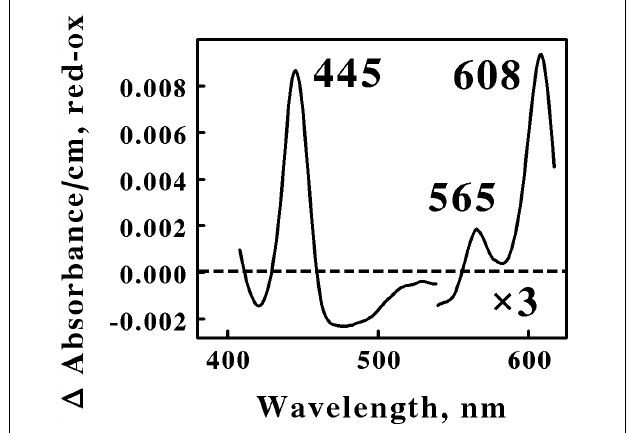
FIGURE 1 | Reduced minus oxidized difference spectra obtained when excess ferrous sulfate was mixed with intact cells of Acidihalobacter ferrooxidans , representing the Proteobacteria. The number of cells present in 8 ml were 2.7 × 10 9 . The bold numbers identify the wavelengths where each peak exhibited its maximum value. The absorbance values in the α β regions of the spectrum were multiplied by 3 to aid in the clarity of